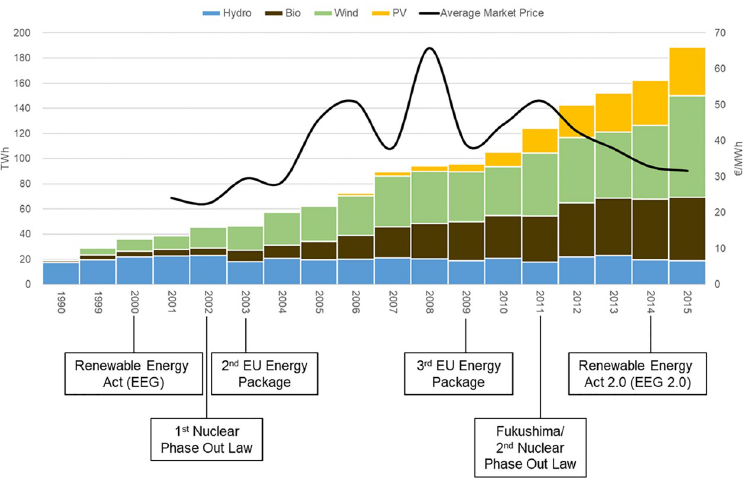
Fig 2. Historic development of generation from renewable energies, average market prices, and market reforms in Germany. Bio = energy from biomass, PV = photovoltaic energy. Sources: Development of renewable energies from ref. [30]; market prices from ref. [31]; and market reforms based on ref. [32].